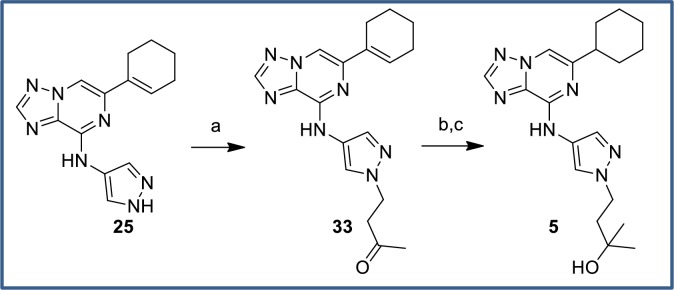
Synthesis of tertiary alcohol 5.Reagents and conditions: (a) but-3-en-2-one, Cs2CO3, DMF, rt, 73%; (b) MeMgBr, THF, rt, 38% (+ 44% recovered 33); (c) Pd(OH)2, H2 (1 atm), MeOH/EtOAc/AcOH, rt, 62%.